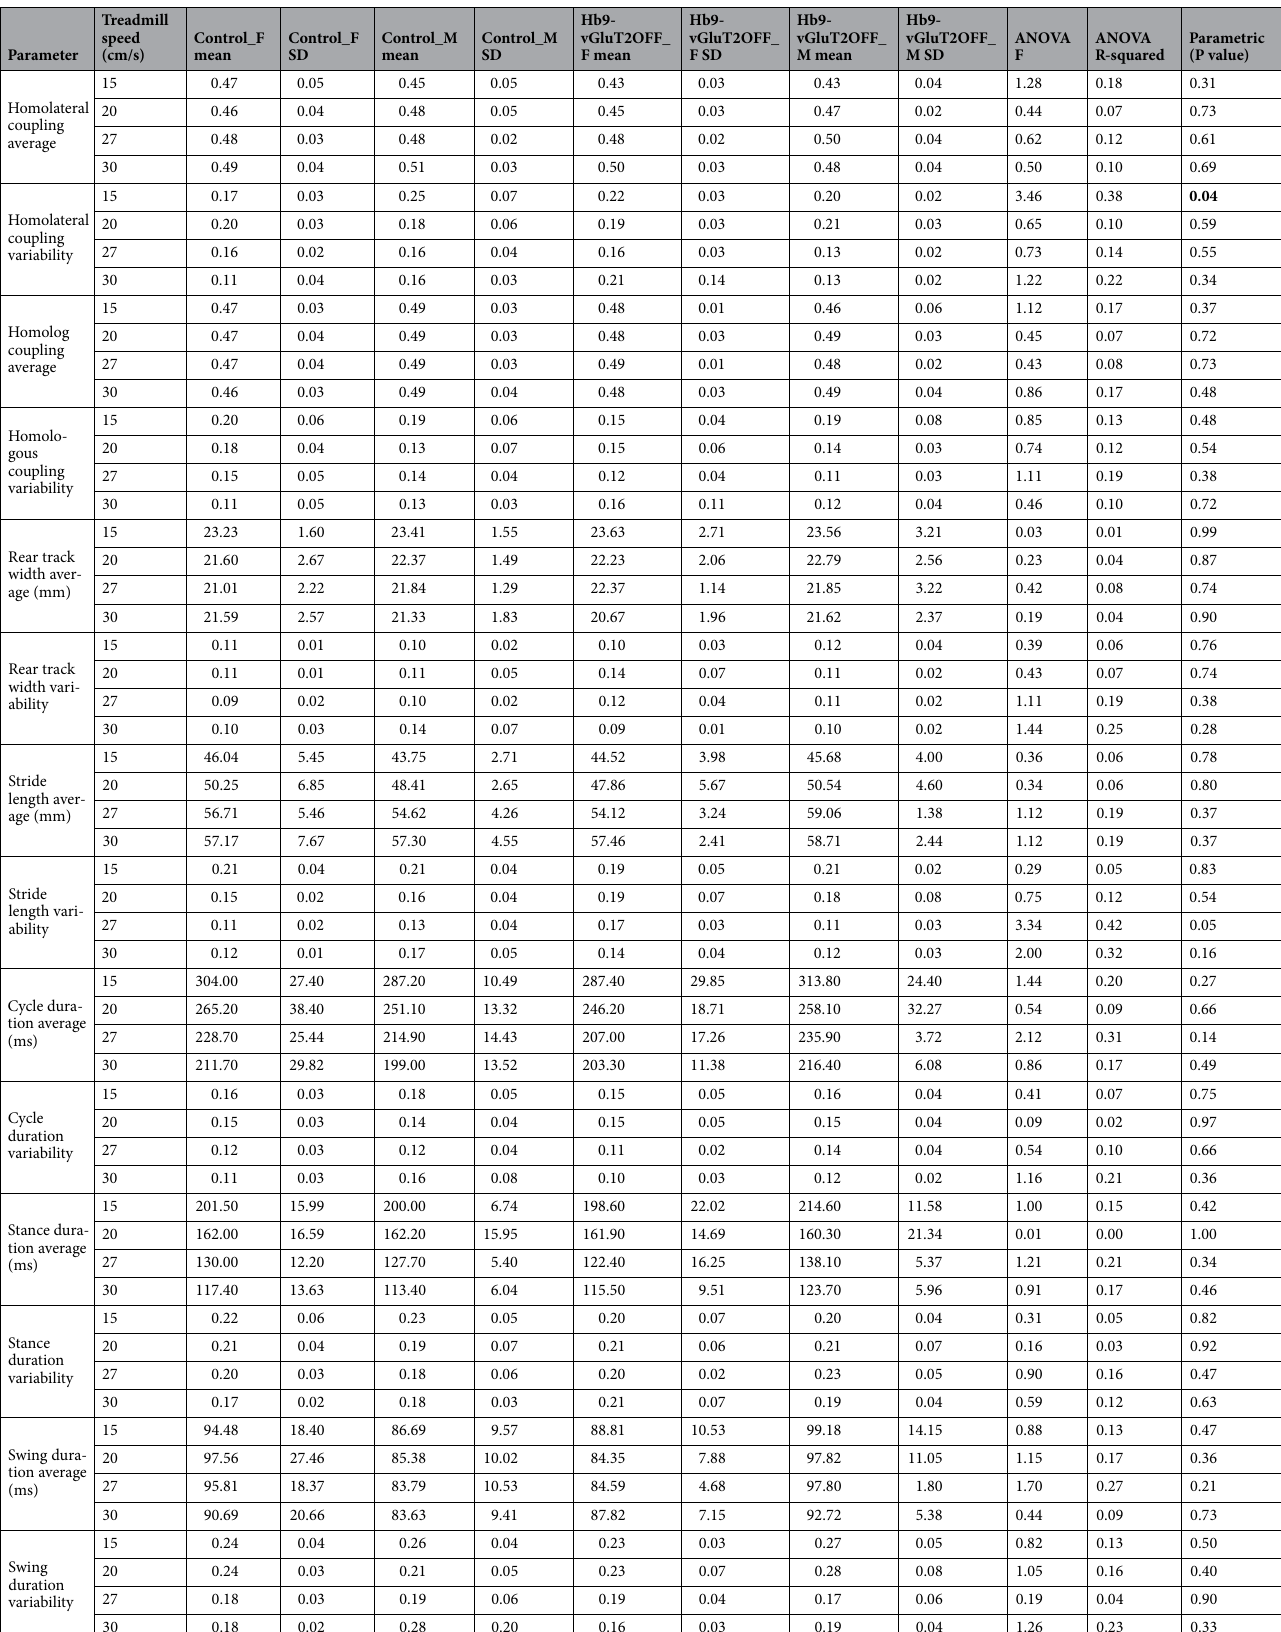
Table 2. Statistics for sex × genotype analysis for treadmill locomotion pattern and timing parameters using one way ANOVA. Bold indicates significant P values. See “Methods” for